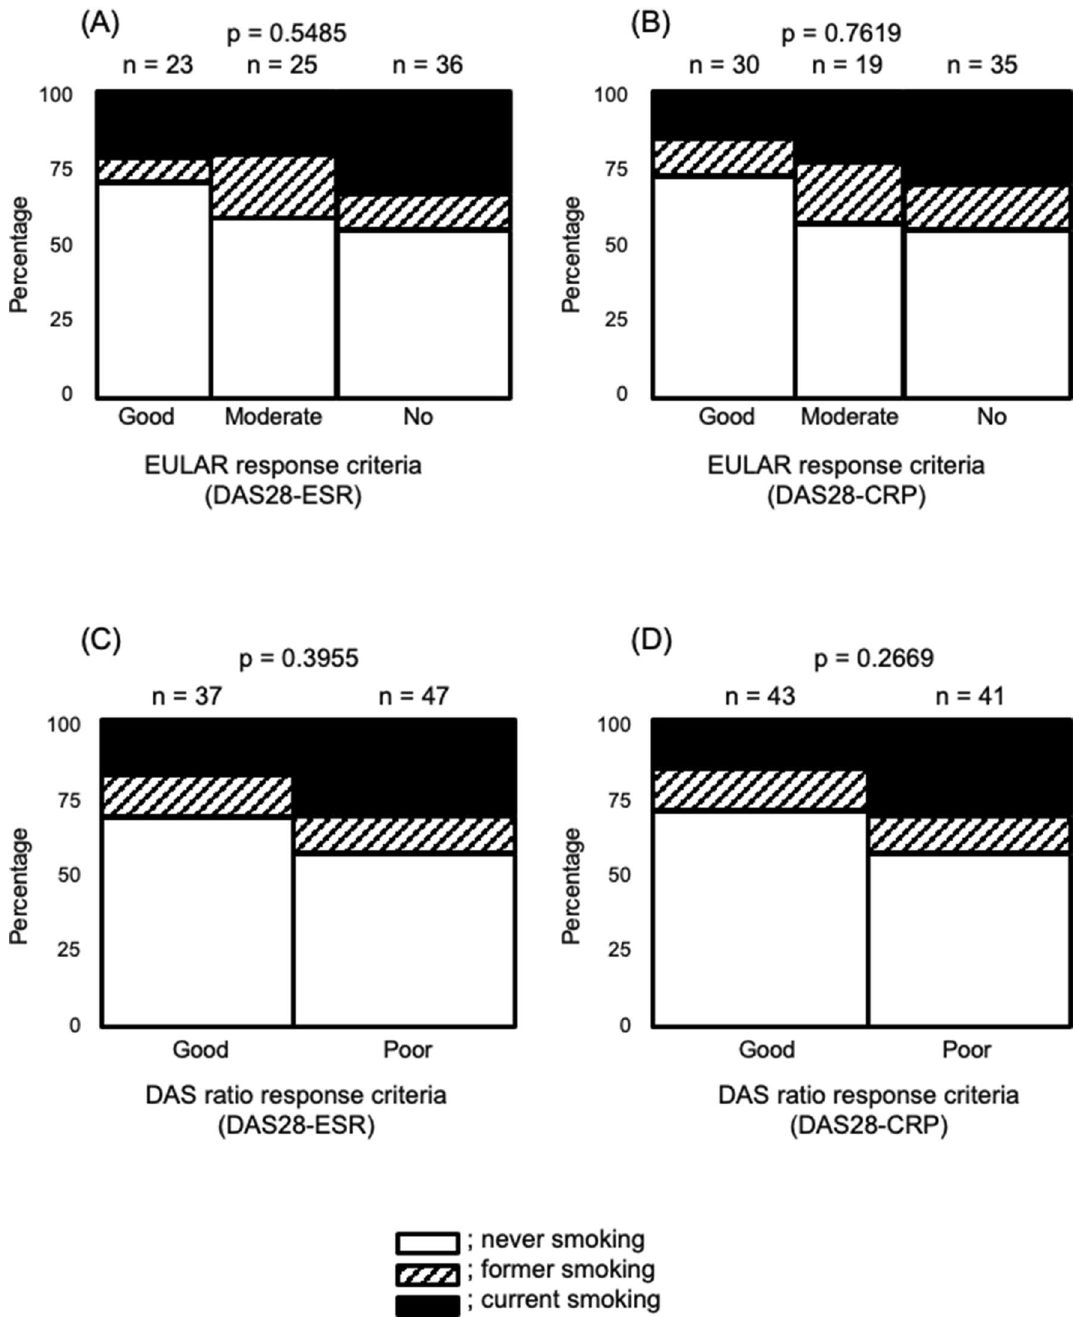
Figure 2. Relationship between therapeutic response and smoking. Shown in the Marimekko Chart ( A , B ) EULAR response criteria; ( C , D ) DAS ratio response criteria; ( A , C ) DAS28-ESR; ( B , D ) DAS28-CRP. Open bar represents never smoking; shaded bar represents former smoking; closed bar represents current smoking. Good responders had little smoking experience; however, there was no significant difference between groups (P-value: Pearson’s chi-square test). CRP C-reactive protein, DAS disease activity score, ESR erythrocyte sedimentation rate, EULAR European Alliance of Associations for